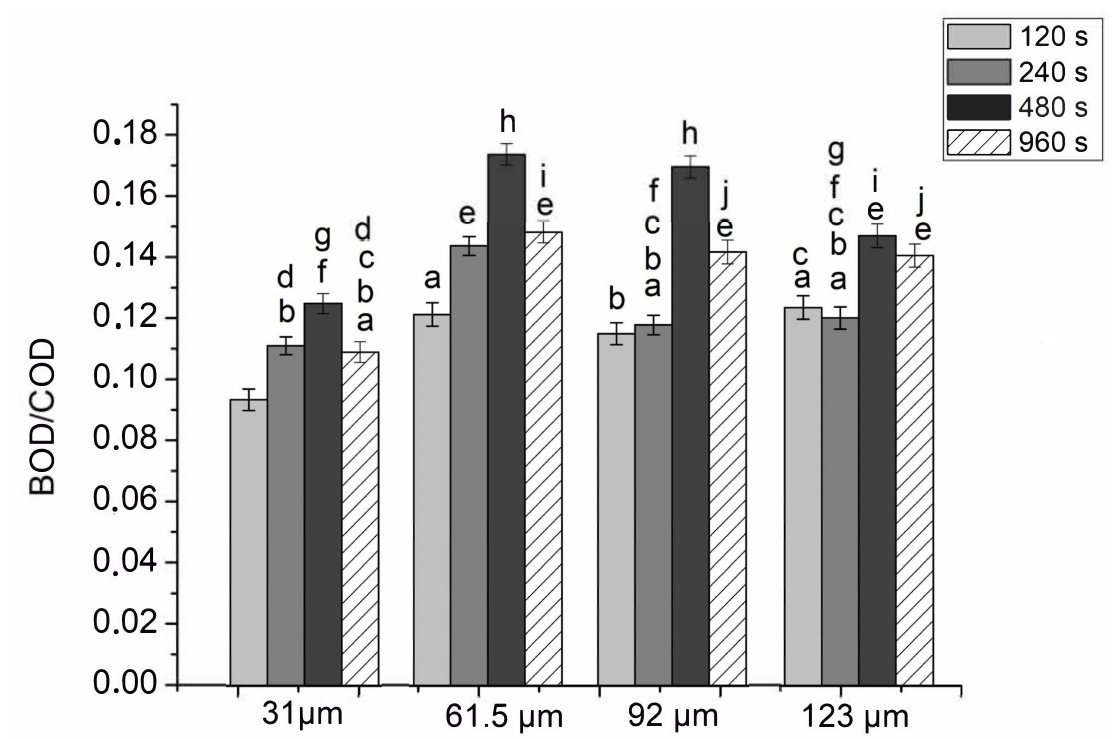
Figure 4. The impact of sonication time and the magnitude of the vibration amplitude on the BOD 5 /COD ratio (Statistical group